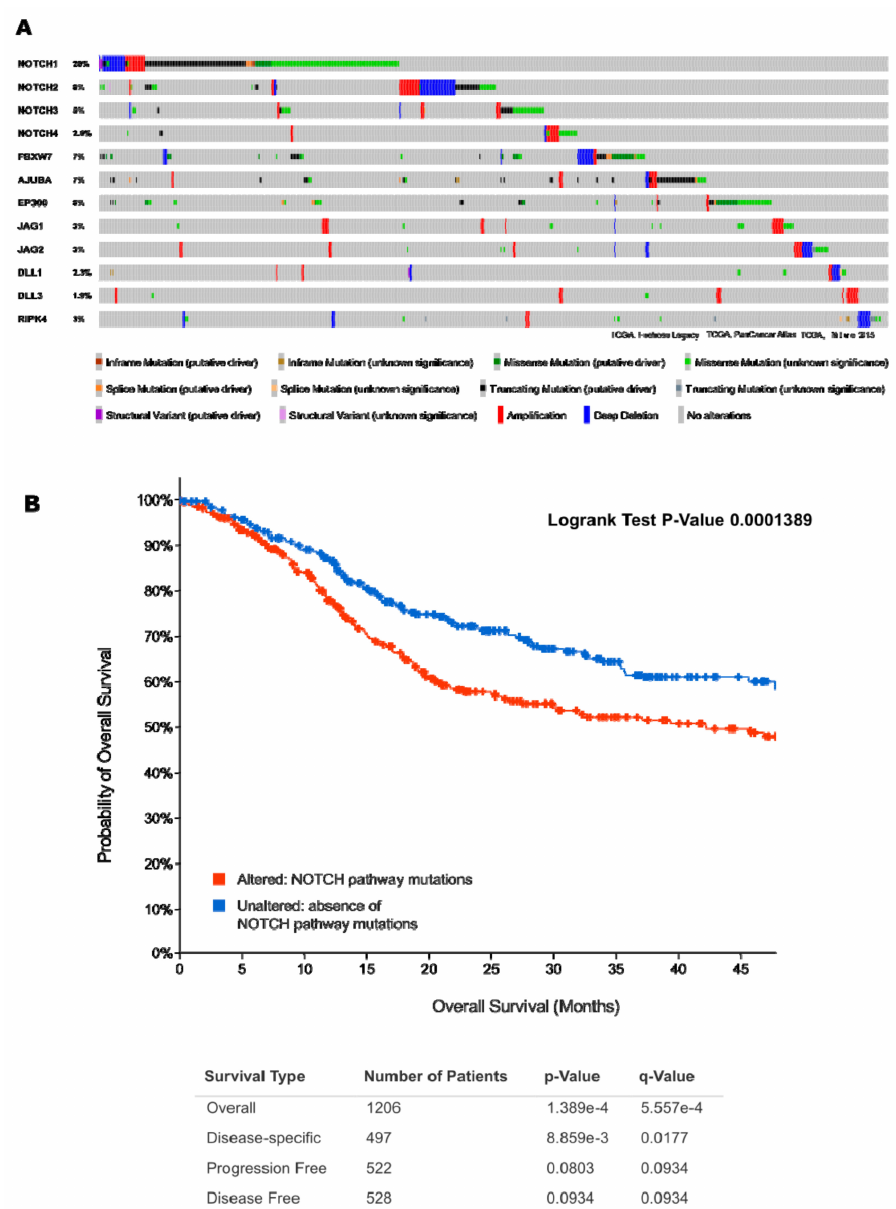
Figure 3. Impact of mutated Notch pathway genes on the survival of head and neck squamous cell carcinoma (HNSCC) patients. ( A ) DNA copy number changes, structural and point mutations of 12 genes central to Notch pathway activity, across 1332 patient with HNSCC from The Cancer Genome Anatomy (TCGA) repository. ( B ) Kaplan–Meier plot indicating significantly different overall and disease-specific survival of HNSCC patients that harbour at least one Notch-pathway related mutation or copy-number change (red), compared to patients without mutations in any of these 12 genes (blue). The same 12 genes were also included in the clinical association studies shown in Figure 4. Conclusion: differential activities of the Notch signalling pathway are likely to affect patients’ therapy response and survival (up to 48